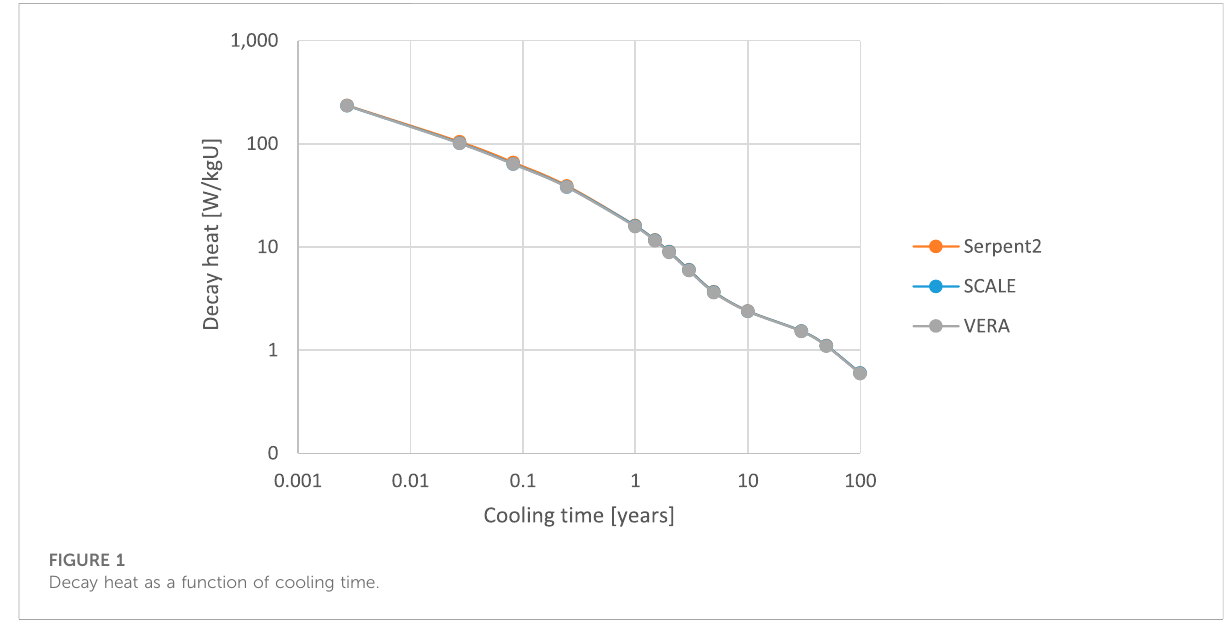
Decay heat as a function of cooling time.